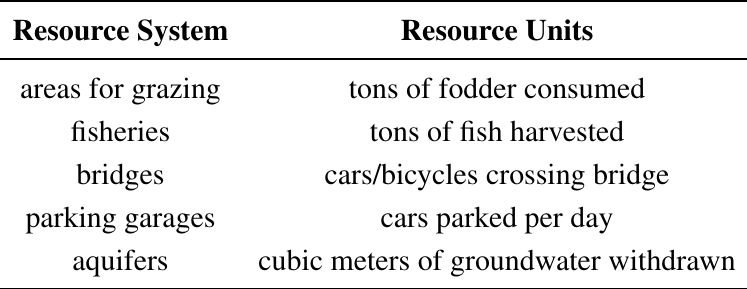
Table 2. Example resource systems and resource units.